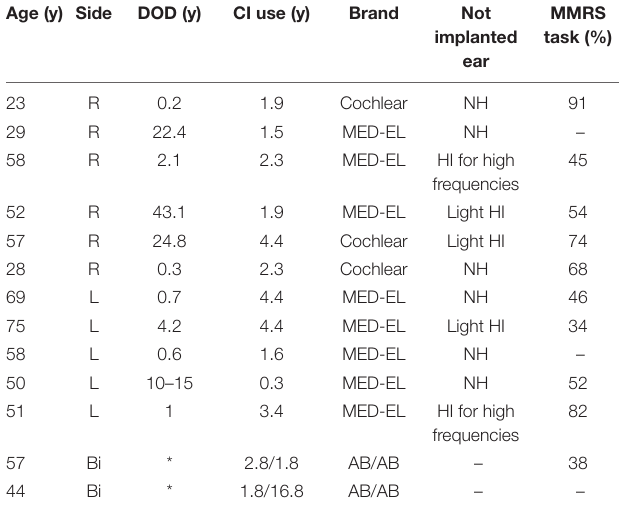
TABLE 1 | Information about the 13 CI users: age, duration of deafness (DOD) (y), CI use (y), implant type (brand), hearing performance of the not implanted ear, and MMRS task performance (hit rate in